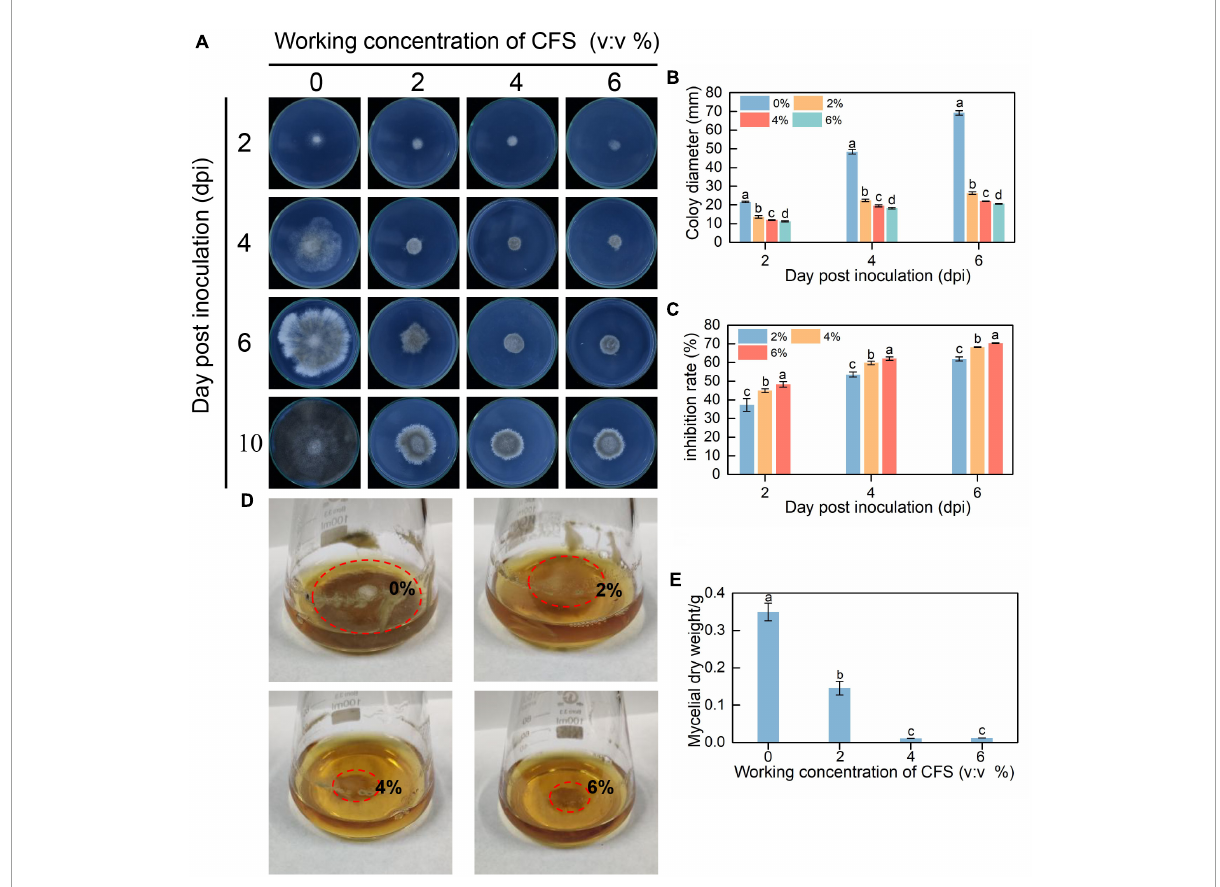
FIGURE1 The cell-free supernatant (CFS) of Bacillus velezensis inhibited vegetative growth of Botrytis cinerea both on PDA (potato dextrose agar) plate (A–C) and in PDB (potato dextrose broth) medium (D,E) . (A) Images were recorded after 2, 4, 6, and 10 days of incubation. (B) Statistical analysis for colony diameters. (C) The inhibition rate of CFS of different concentrations. (D) Images were recorded after 3 days of incubation, and the red circles represent the mycelia ball in different concentrations of CFS. (E) Statistical analysis for mycelial dry weight. The experiments were conducted in triplicate, and the data shown are means ± standard deviations ( n = 5). According to Duncan’s multiple range test, columns marked by different letters represented statistically different. ( p <